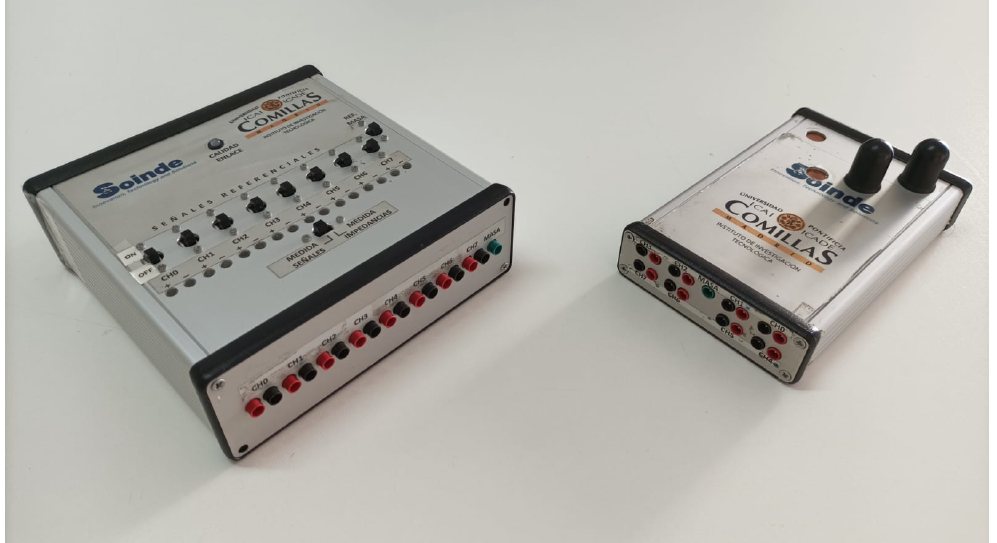
Figure 4. Photo of the complete prototype; left side, the receiver, which will rebuild the original signals; right side, the transmitter, to which the electrodes will be